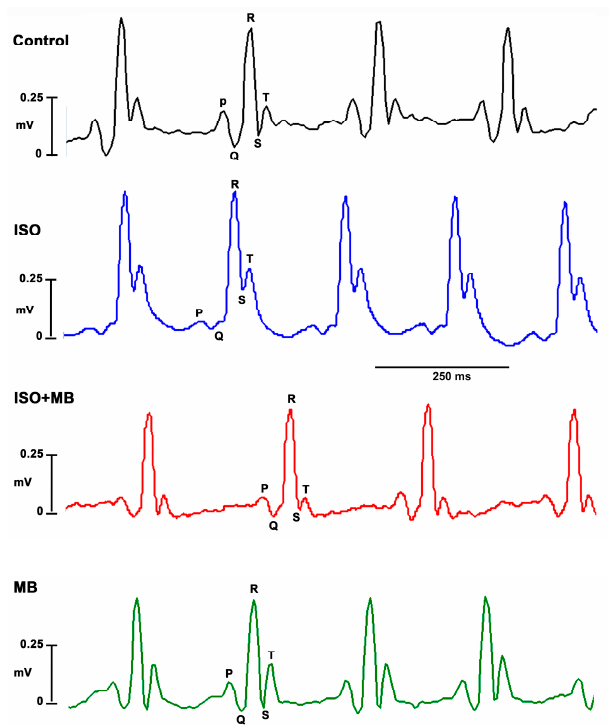
Figure 1. Electrocardiograms (ECG) showing the bradycardic effects of M. bijugatus extract (MB, 100 mg/Kg) in myocardial injury. Control shows the normal electrocardiograph. ISO (85 mg/Kg) shows an elevated ST segment; ISO + MB shows a restored ST segment.